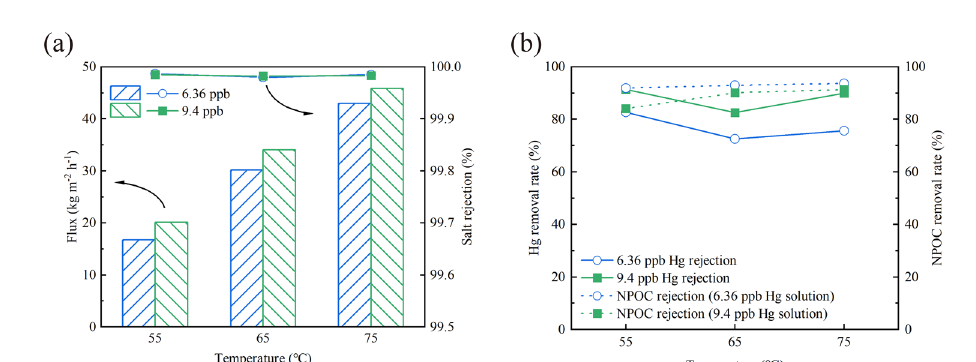
Fig. 7 Photographs of Hg- containing wastewater samples before and after PV treatment. a 6.36 ppb feed solution, PV retentate solution and PV per- meate; b 9.4 ppb feed solution, PV retentate solution and PV permeate (from left to